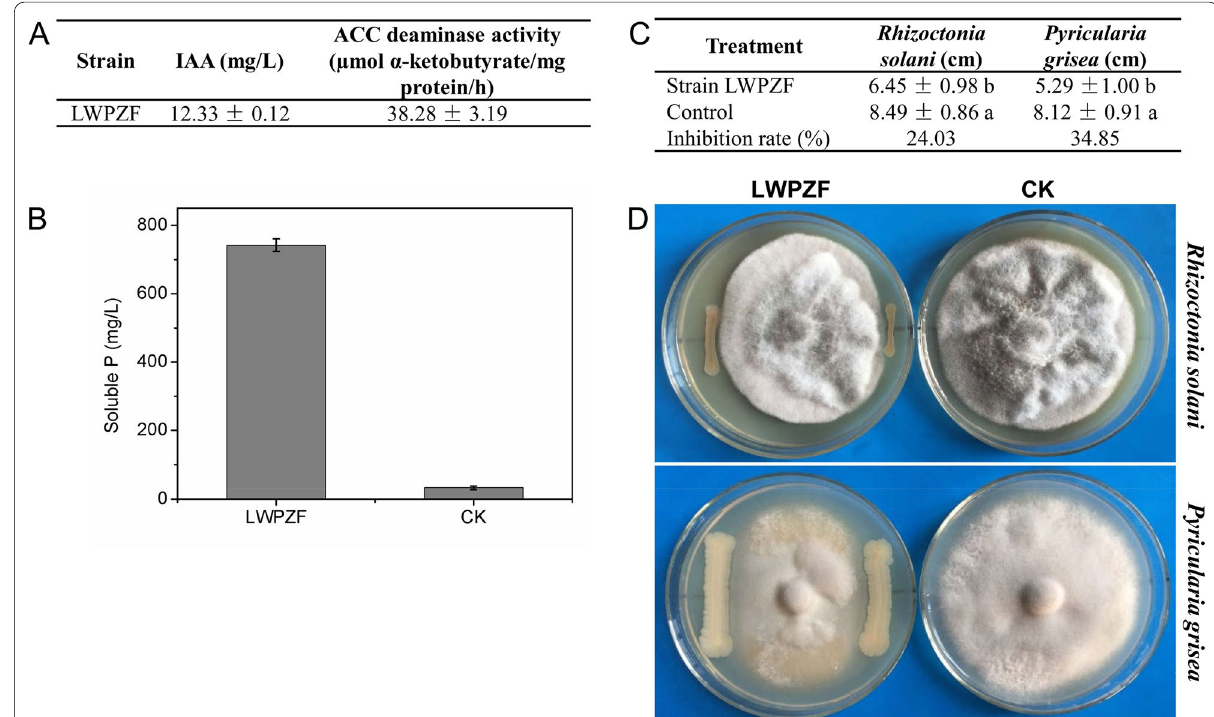
Fig. 2 Traits involved in PGPR activity and antagonistic function of LWPZF. A IAA production and ACCD activity; B Phosphate solubilization; C , D Antagonistic function of LWPZF to Rhizoctonia solani and Pyricularia grisea . Different letters indicate significant differences ( P < 0.05)